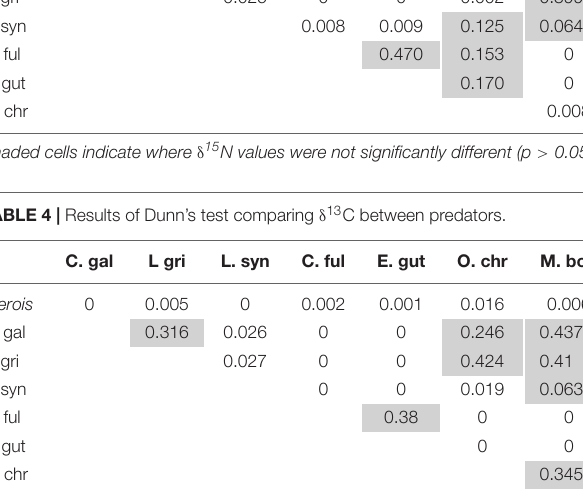
TABLE 3 | Results of Dunn’s test comparing δ 15 N between predators.